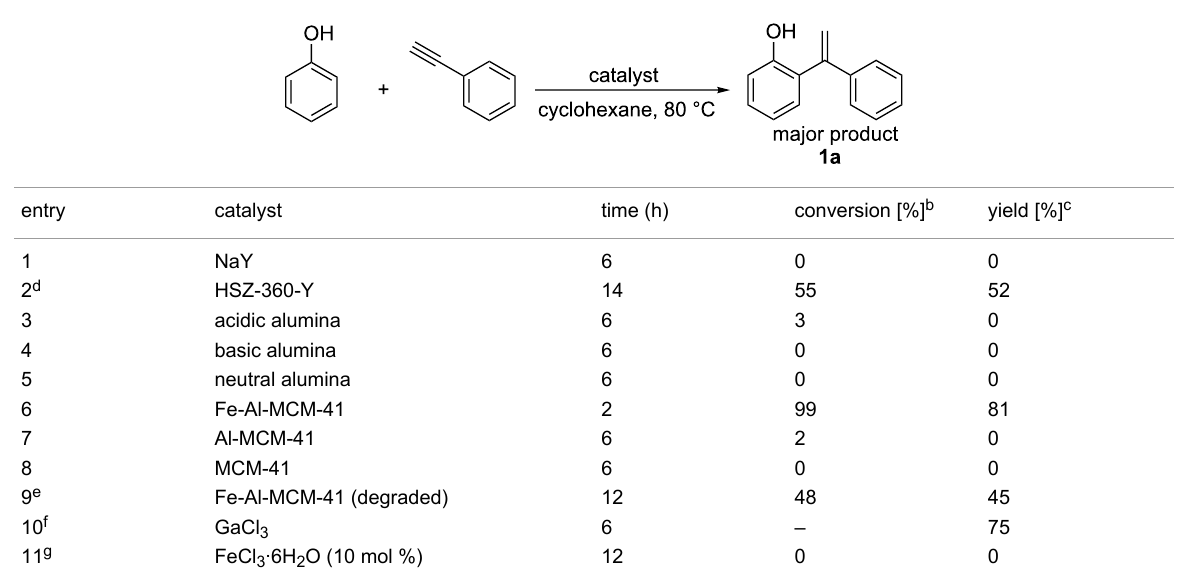
Table 2: Reactions of phenylacetylene with phenol with different catalysts a .